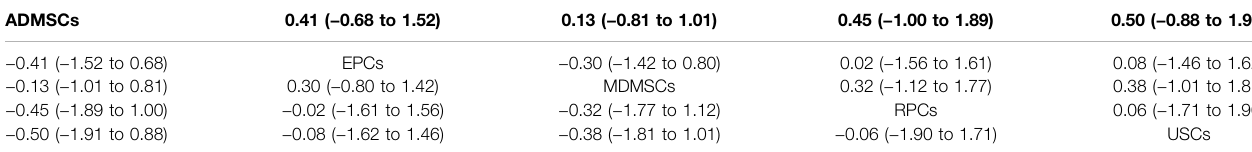
TABLE 6 | Network Meta-analysis results of serum creatinine levels in stem cell groups at 14 days after administration. ADMSCs 0.41 ( − 0.68 to 1.52) 0.13 ( − 0.81 to 1.01) 0.45 ( − 1.00 to 1.89) 0.50 ( − 0.88 to 1.91) − 0.41 ( − 1.52 to